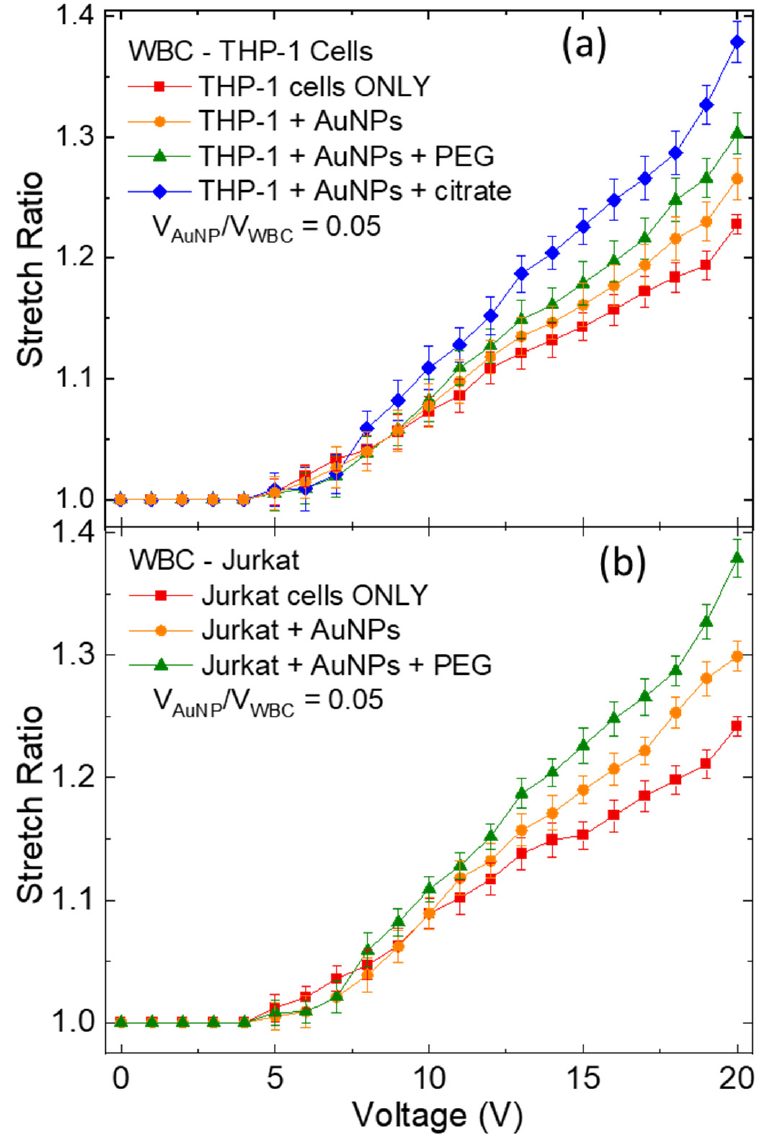
Figure 5. ( a ) Stretch ratio measured as a function of the applied voltage for THP-1 white blood cells (WBC). In addition to “cells only” and “nanoparticles enriched WBCs”, we used PEG-ylated and citrated solutions of AuNPs, as discussed in the main text. ( b ) Same study, but for the Jurkat type WBCs. Elliptical deformation is assumed during analysis of cells’ images. The concentration of AuNPs, in the form of a volume fraction of the overall cell medium, was kept at 5%.